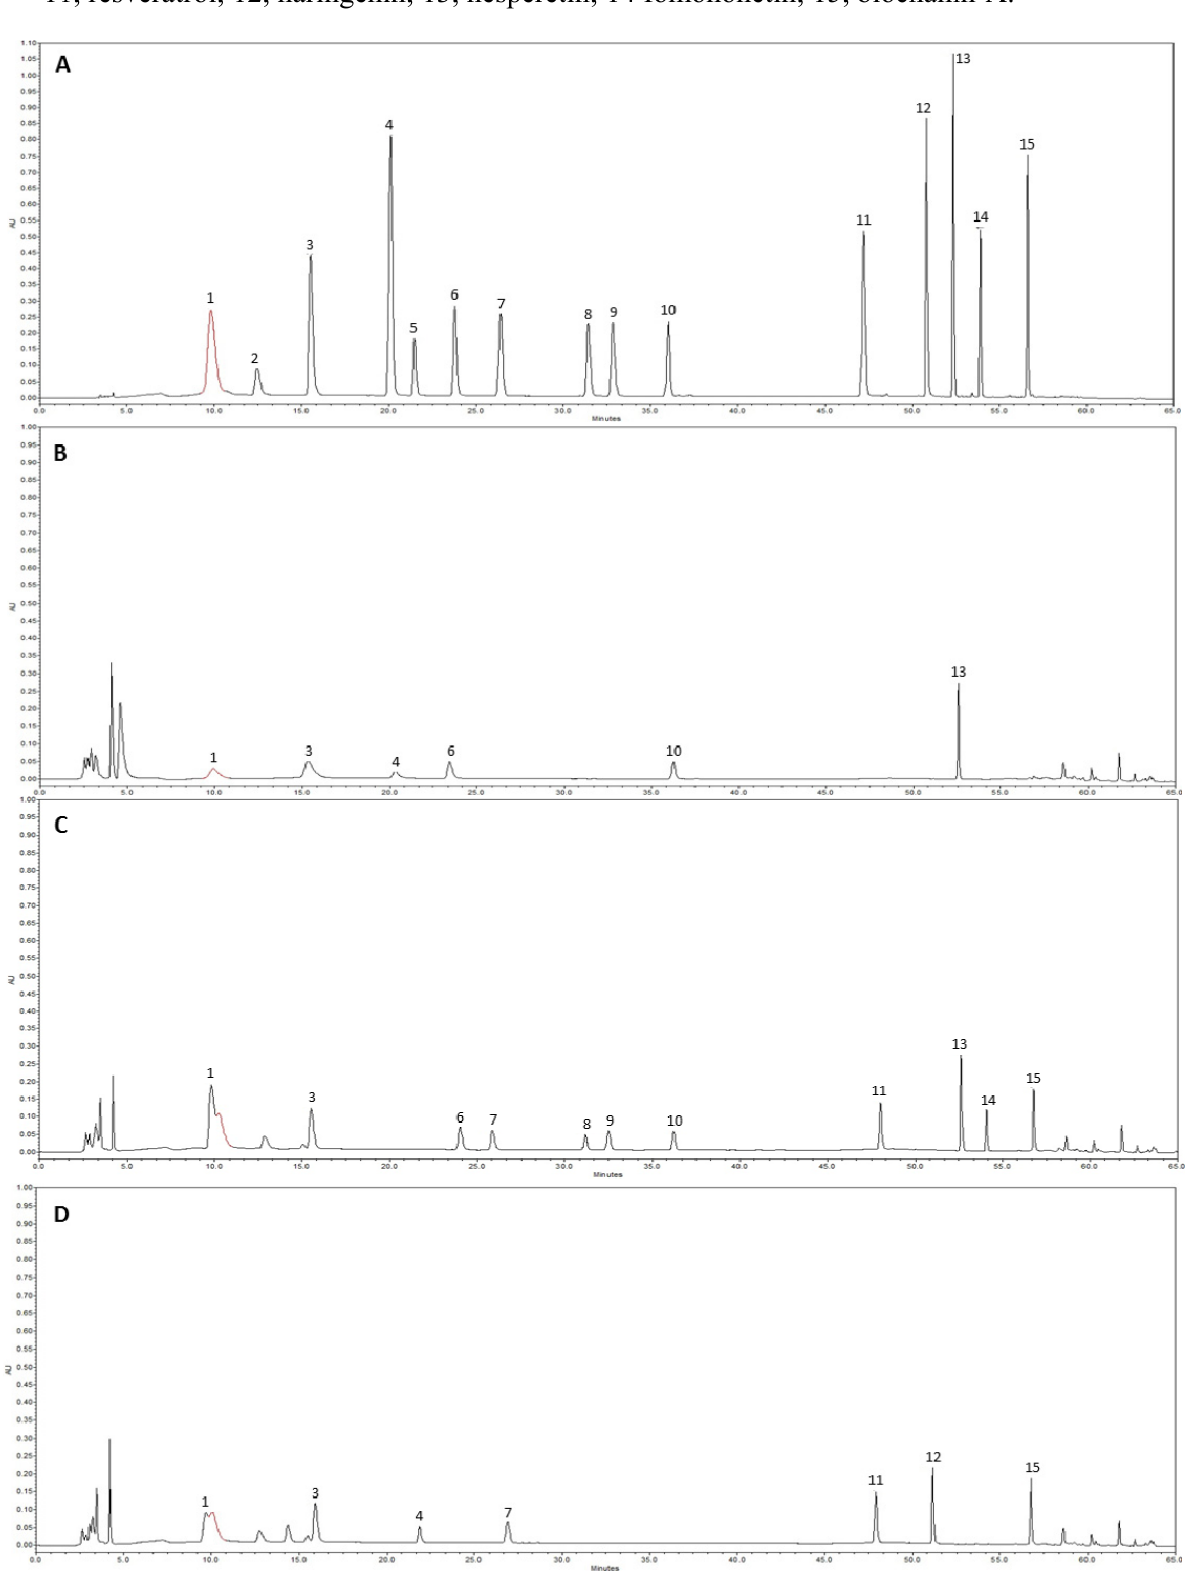
Figure 3. High performance liquid chromatography of phenolic compounds. ( A ) standard mixture of 15 phenolic compounds; ( B ) methanol extract; ( C ) acetone extract; ( D ) hot- water extract. 1, gallic acid; 2, pyrogallol; 3, homogentisic acid; 4, protocatechuic acid; 5, (+)-catechin; 6, chlorogenic acid; 7, caffeic acid; 8, vanillin; 9, ferulic acid; 10, naringin; 11, resveratrol; 12, naringenin; 13, hesperetin; 14 fomononetin; 15,